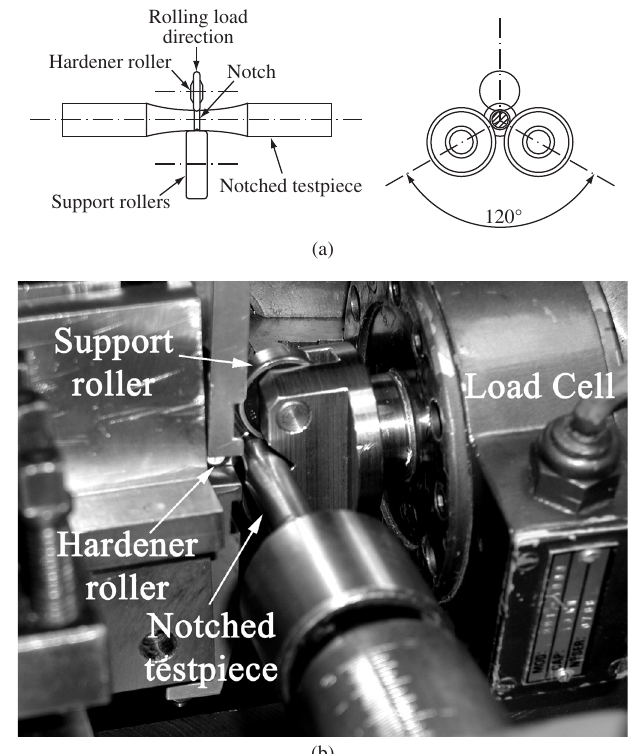
Figure 4. Surface rolling apparatus: a) Schematic representation; b) photo- graph of the equipment.